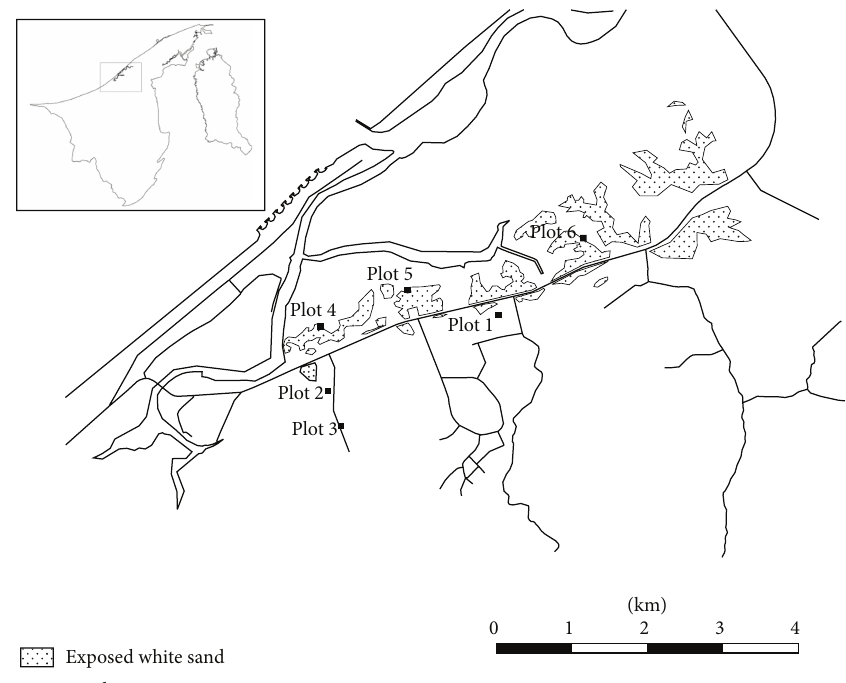
Figure 1: Location of the study sites in Kerangas forests of the Tutong White Sands along the Tutong–Belait Highway. Six 20 m × 20 m plots were established within intact Kerangas forests, and adjacent to the exposed white sands area. The location of the Tutong White Sands within Brunei Darussalam is shown in the